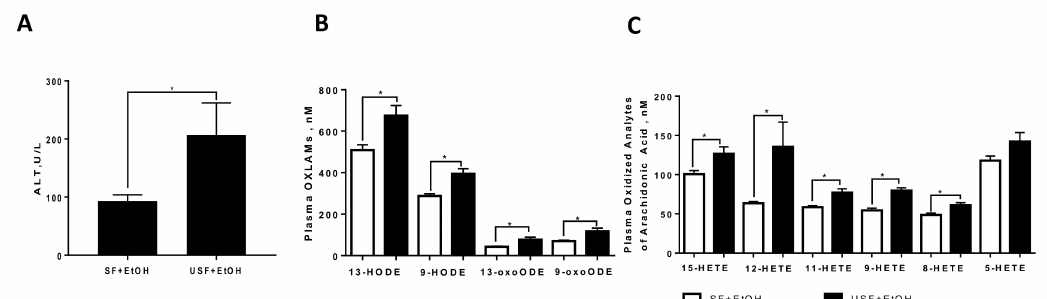
Figure 1. Elevated levels of polyunsaturated fatty acid (PUFA) metabolites in liver injury caused by acute-on-chronic ethanol administration. ( A ) Plasma alanine aminotransferase (ALT) levels were significantly higher in mice fed ethanol and unsaturated fat compared to ethanol and dietary saturated fat; ( B ) oxidized metabolites of linoleic acid; ( C ) oxidized metabolites of arachidonic acid. SF: saturated fat; EtOH: ethanol-fed; USF: unsaturated fat; HODE: hydroxyoctadecadienoic acids; HETE: hydroxyeicosatetraenoic acids; * p <